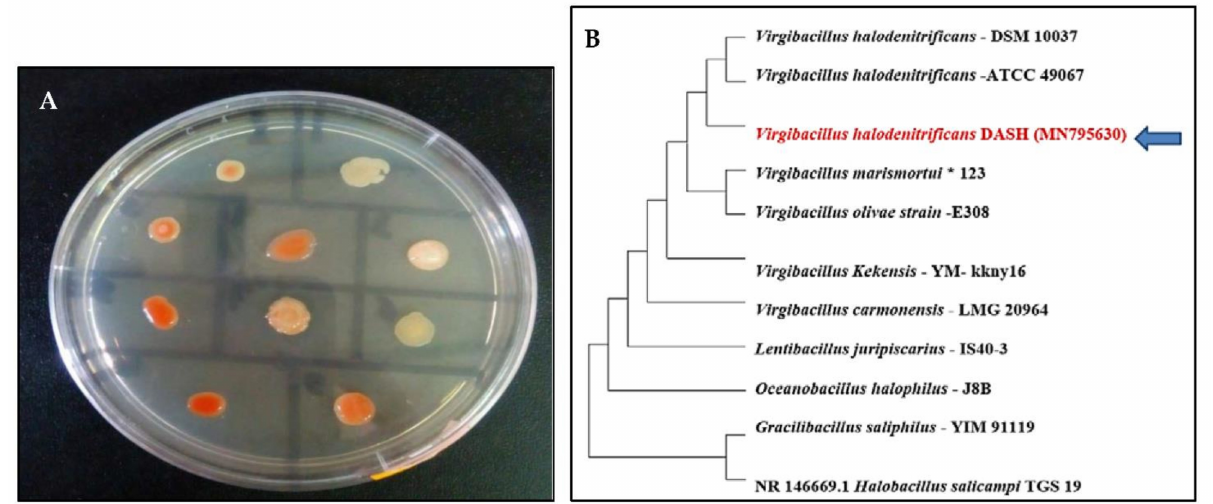
Figure 1. IRAM plate showing bacterial isolates screened from Wadi El-Natrun’s Salt Lakes with different pigment production capabilities ( A ) and the phylogenetic tree showing the position of the selected halophilic bacterial isolate Virgibacillus halodenitrificans DASH- MN795630 ( B ).